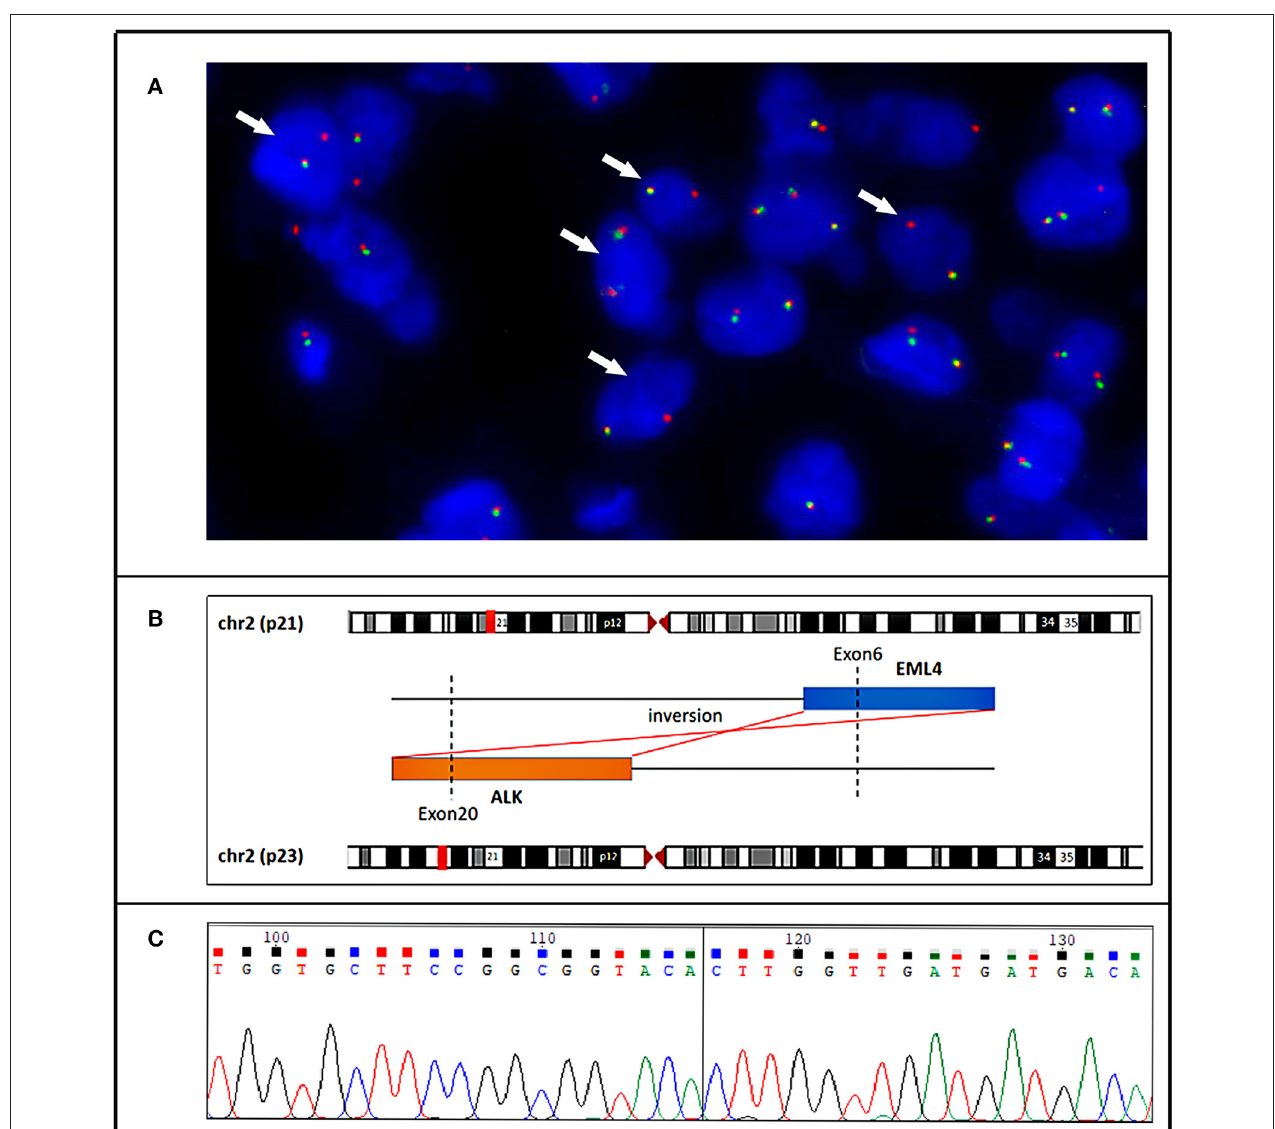
FIGURE 3 | Case 1. (A) Fluorescence in situ hybridization demonstrating an unbalanced rearrangement of the ALK locus in the neoplastic cells (loss of a green signal with an extra red signal). (B) Next generation sequencing (NGS-) based technology showing detection of ALK (exon 20) and EML4 (exon 6) fusion and breakpoint information between the two genes. (C) A partial nucleotide sequence of the EML4-ALK fusion transcript, and the fusion site (arrow) involved exon 20 of the ALK gene and exon 6 of the EML4